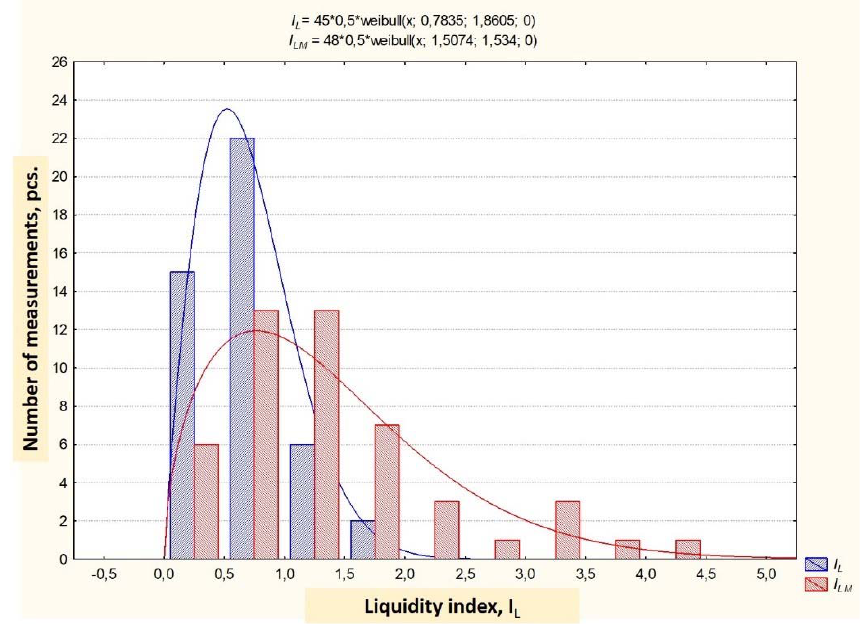
Figure 4. Distribution of the flow index of thawed IL and frozen IL m (during thawing) cohesive soils in the Obskaya–Salekhard line section.